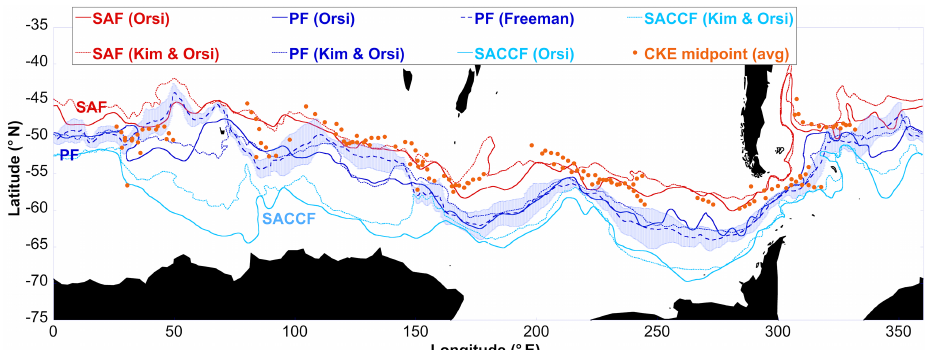
Figure 6. Mean positions of fronts estimated from CKE (orange dots) along with estimates from other authors: Orsi et al. (1995), computed using hydrographic sections; Kim and Orsi (2014), based on contours of dynamic topography; and Freeman and Lovenduski (2016a), based on gradients of sea surface temperature. The Orsi et al. (1995) fronts were downloaded from https://gcmd.nasa.gov/records/AADC_southern_ ocean_fronts.html. The Freeman and Lovenduski fronts were downloaded from https://doi.pangaea.de/10.1594/PANGAEA.855640 (Free- man and Lovenduski, 2016b). The Kim and Orsi (2014) fronts were provided by Yong Sun Kim upon